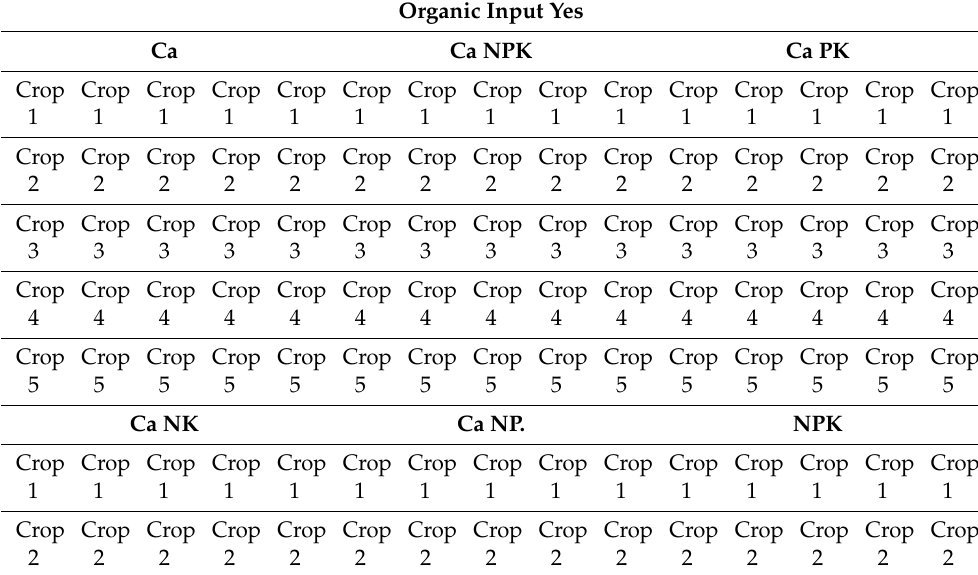
Table A1. Field plan of the Skierniewice long-term experiment (1966–2015). Five-year crop